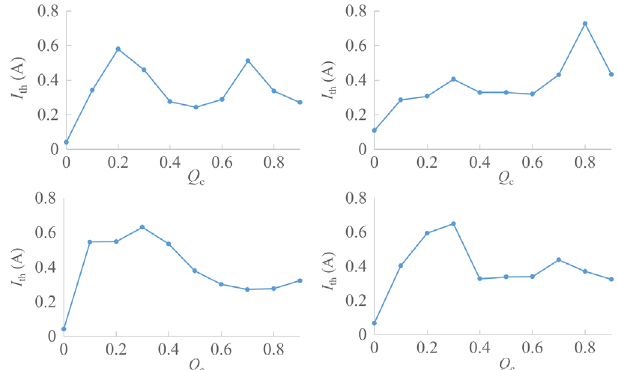
FIG. 11. Minimal threshold current for different modes in S-DALINAC. Four of the most dangerous quadrupole mode pairs are enclosed in a green box.